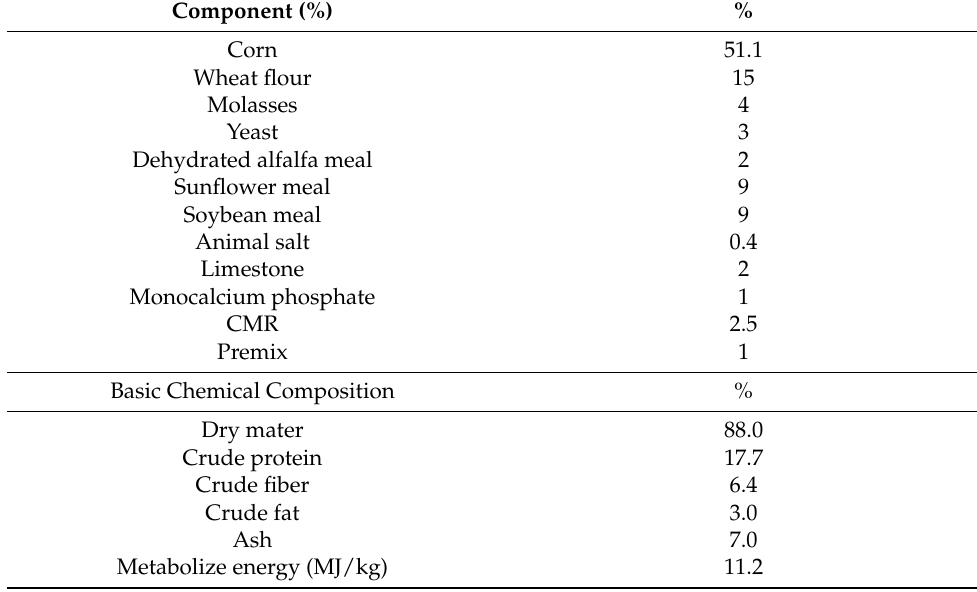
Table 1. Ingredients and chemical composition of the basal feed